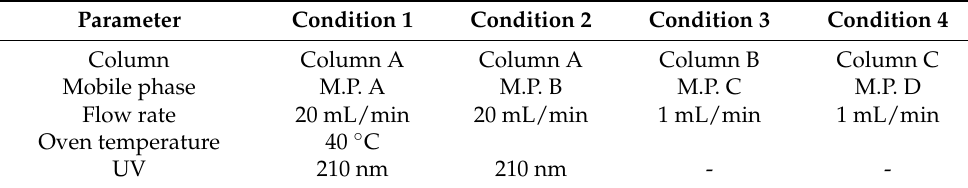
Table 1. Analytical conditions of HPLC-UV, HPLC-MS, and HPLC-MS/MS.